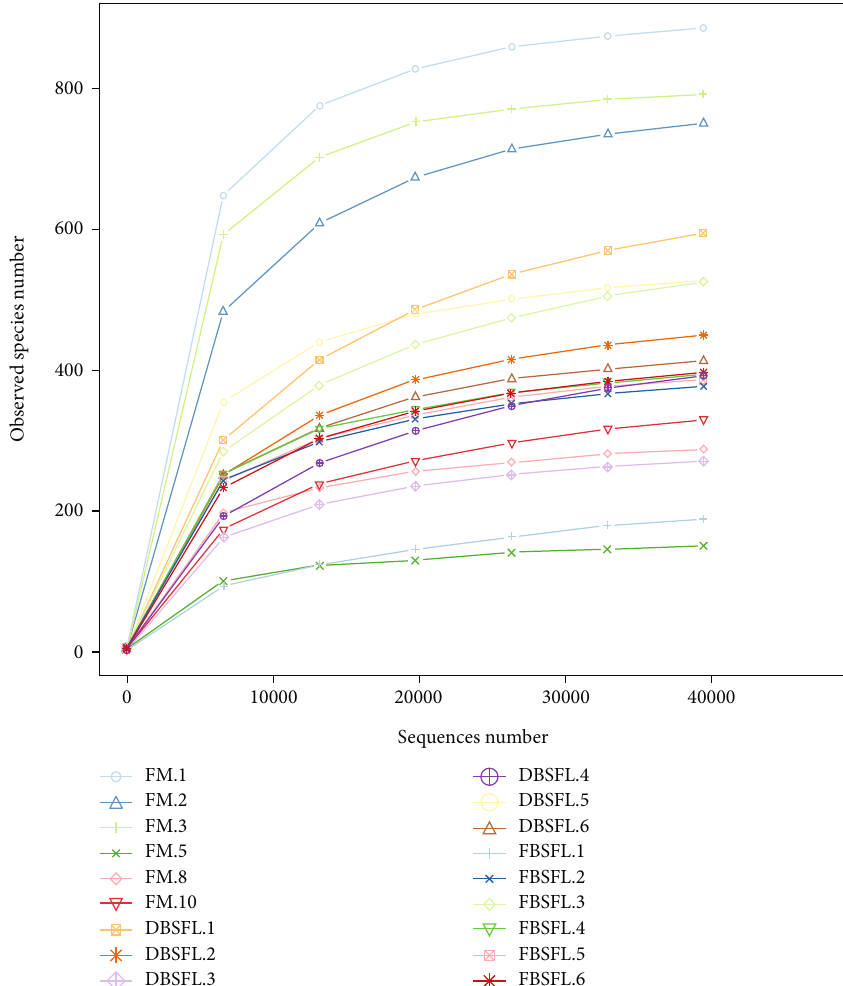
Figure 3: Rarefaction curve of intestinal microbiota on turbot. Abbreviations: FM.1, FM.2, FM.3, FM.5, FM.8, and FM.10 were the six samples of the FM group; DBSFL.1, DBSFL.2, DBSFL.3, DBSFL.4, DBSFL.5, and DBSFL.6 were the six samples of the DF group; FBSFL.1, FBSFL.2, FBSFL.3, FBSFL.4, FBSFL.5, and FBSFL.6 were the six samples of the FF